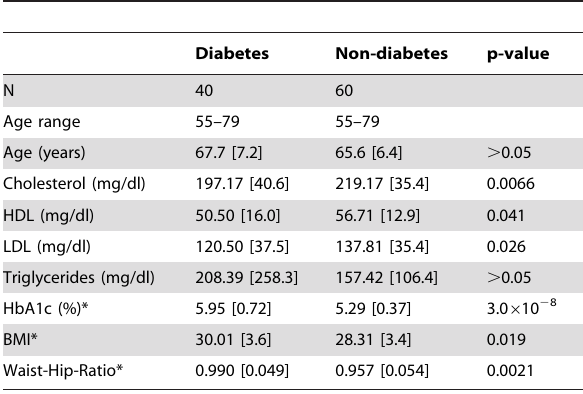
Table 1. Characteristics** of the diabetic and the control